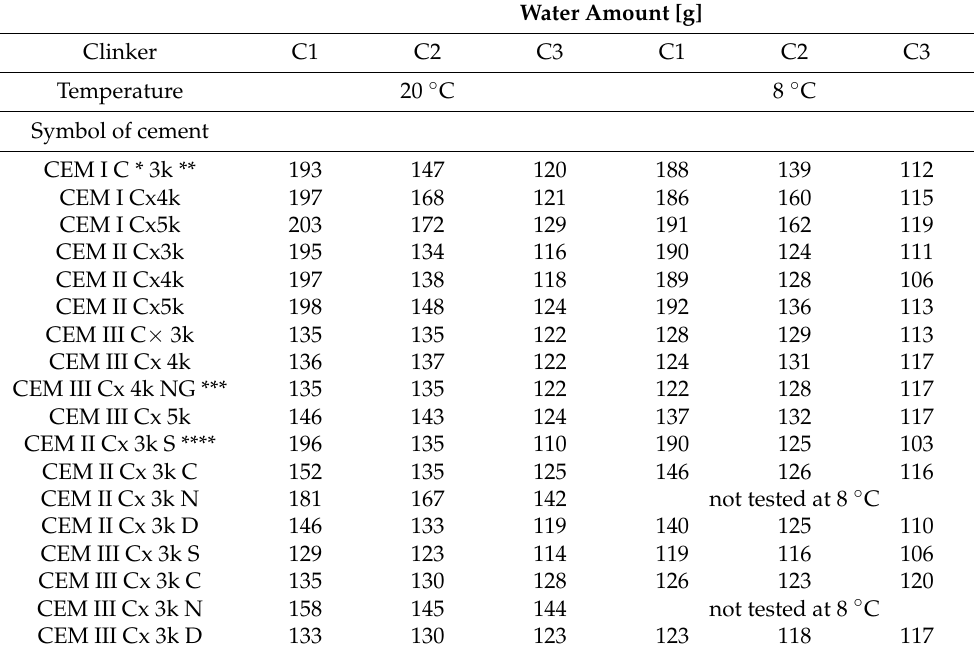
Table 7. Water demand depending on cement type, accelerator used, and